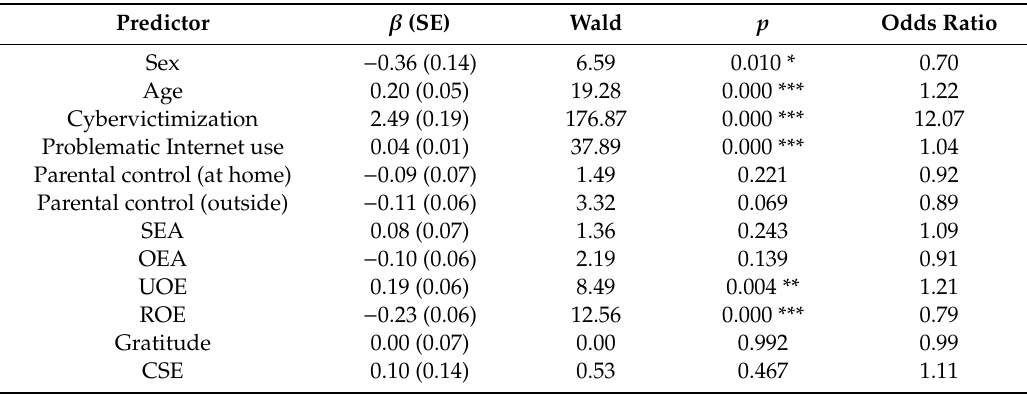
Table 4. Binary logistic regression analyses predicting cyberbullying